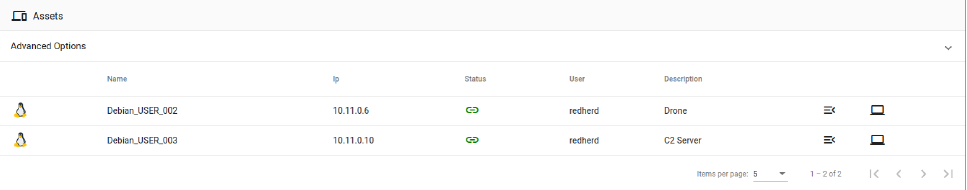
Figure 9. List of assets joined to the RedHerd